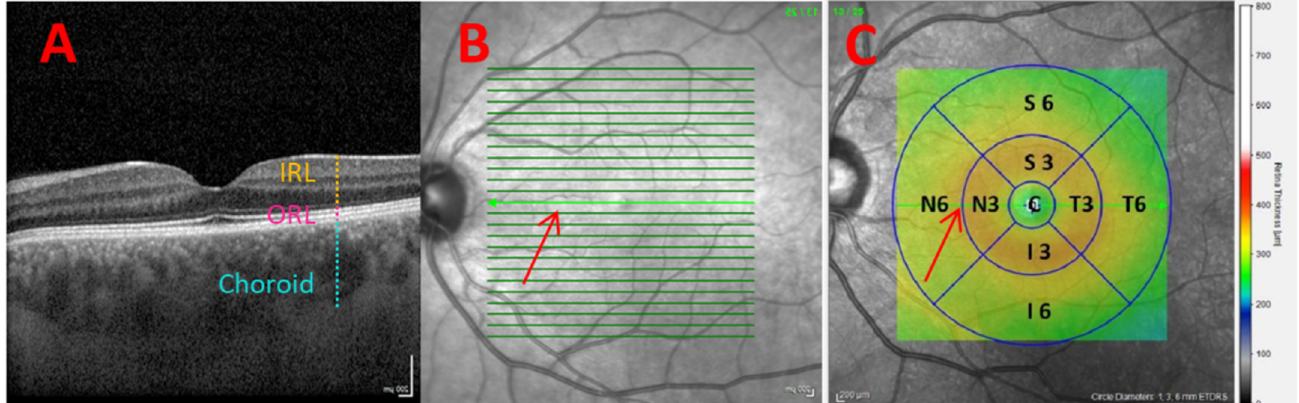
Figure 1. ( A ) Tomographic image of the central B-scan indicating inner retinal layer (IRL), outer retinal layer (ORL), and choroid. ( B ) 25 B-scans at 30° centered on the fovea, indicating the selected one with the red arrow. ( C ) The 9 Early Treatment Diabetic Retinopathy Study (ETDRS) areas for a left eye.